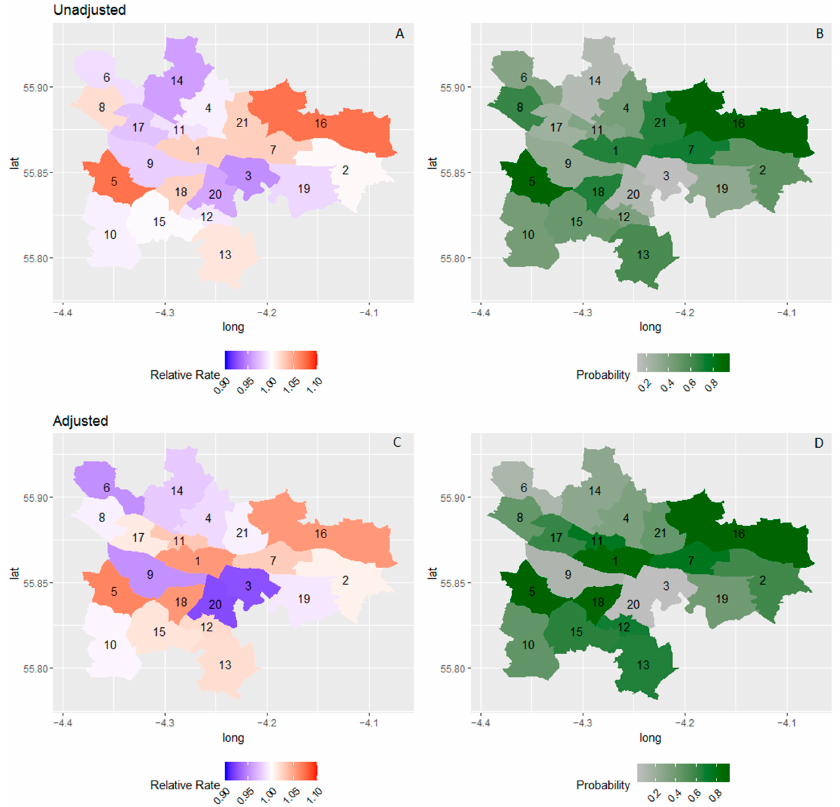
Figure 3. Relative rate increase in average total difficulties scores before ( A ) and after ( C ) and ad- justment and exceedance probability before ( B ) and after ( D ) and adjustment for sex, age, cohort, and deprivation. 1. Anderston/City, 2. Baillieston, 3. Calton, 4. Canal, 5. Craigton, 6. Drum- chapel/Anniesland, 7. East Centre, 8. Garscadden/Scotstounhill, 9. Govan, 10. Greater Pollok, 11. Hillhead, 12. Langside, 13. Linn, 14. Maryhill/Kelvin, 15. Newlands/Auldburn, 16. North East, 17. Partick West, 18. Pollokshields, 19. Shettleston, 20. Southside Central, 21.